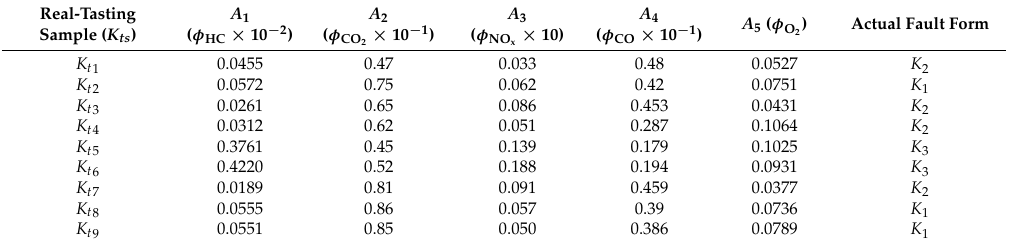
Table 2. Tasting samples of exhaust emission for the engine EQ6102. Real-Tasting Sample ( K ts )